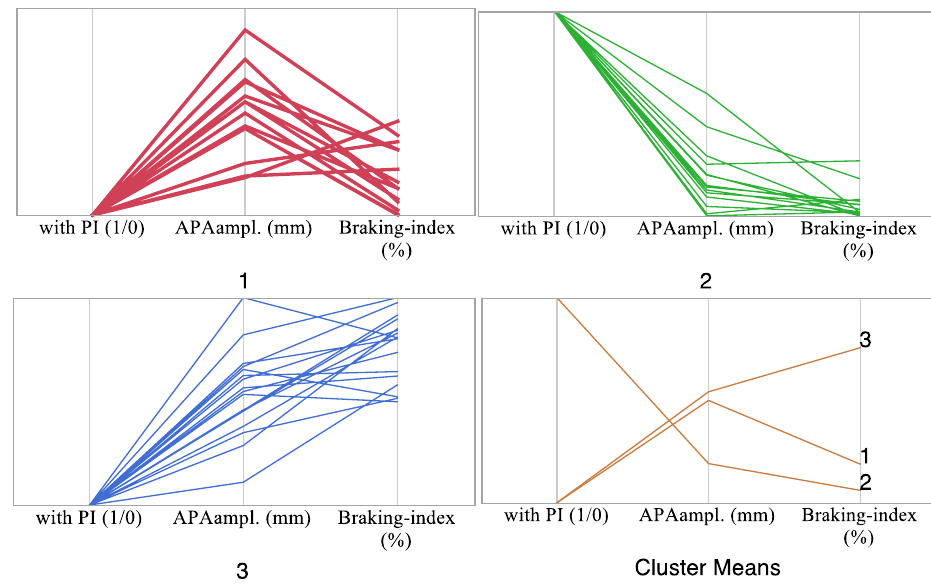
Figure 3. K-Means clustering method. Parallel coordinate plots for the display of the structure of the observations in each cluster showing how the clusters differ. Cluster 2 tends to have comparatively low APA amplitude and Braking-index values and postural